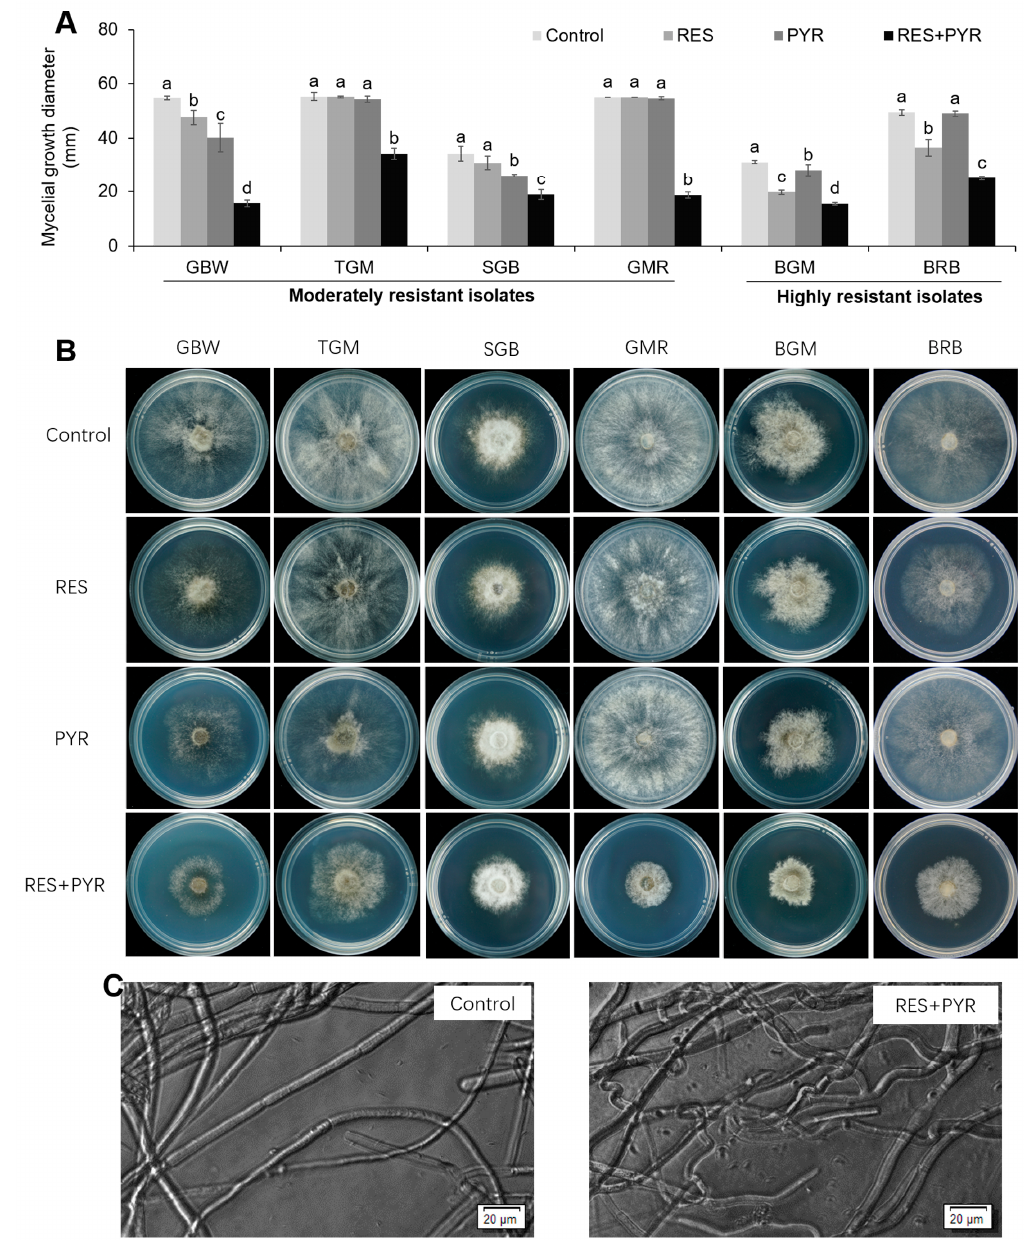
Figure 1. Inhibition on Botrytis cinerea mycelial growth by resveratrol and pyrimethanil treatment, alone or in combination. Six tested isolates were cultured on the PDA medium without (control) or with drugs (resveratrol at 50 mg/L, pyrimethanil at 3.125 mg/L and their combination). Mycelial growth diameter was measured ( A ) and photographed ( B ) at 72 h post incubation. Also, the morphology of untreated mycelial (control) or mycelia treated with two-drug combination for 72 h were observed and imaged by optical microscopy ( C ). RES and PYR represent resveratrol and pyrimethanil used alone, respectively. RES+PYR represent resveratrol and pyrimethanil used in combination. Data was presented as mean ± SE (standard error), and same isolate followed by different letters indicate significant ( p < 0.05) differences according to Duncan’s multiple range test.